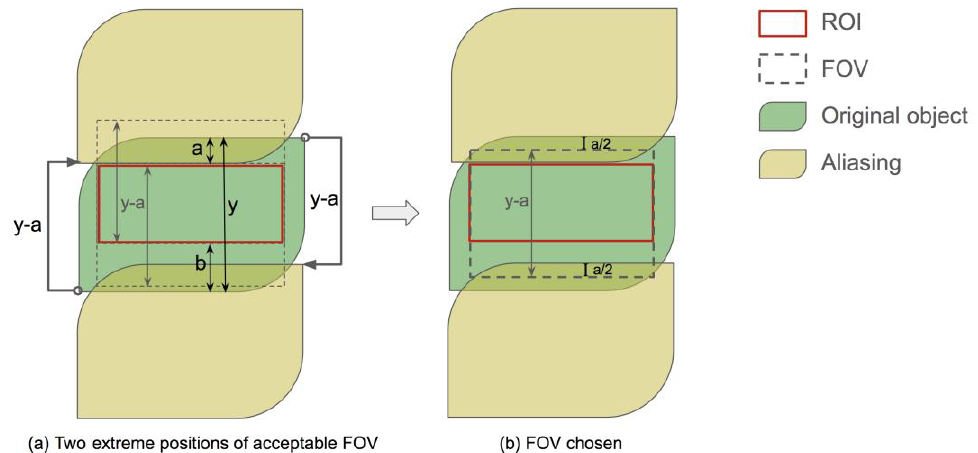
Figure 5. Determination of the smallest FOV in the phase encoding direction (i.e., up-down direction in the figure) to achieve an aliasing-free ROI. The object is aliased to integer numbers of FOV away from the original position, and two of the closest copies are shown in the figure. Given a ≤ b , the smallest FOV width to keep the ROI alias-free is y − a . The position of the FOV does not affect the alias-free region, but we need the ROI to be in the FOV. ( a ) shows two FOVs at the extreme positions to fully include the ROI, and everything in between is acceptable. The position we used for this work is shown in ( b